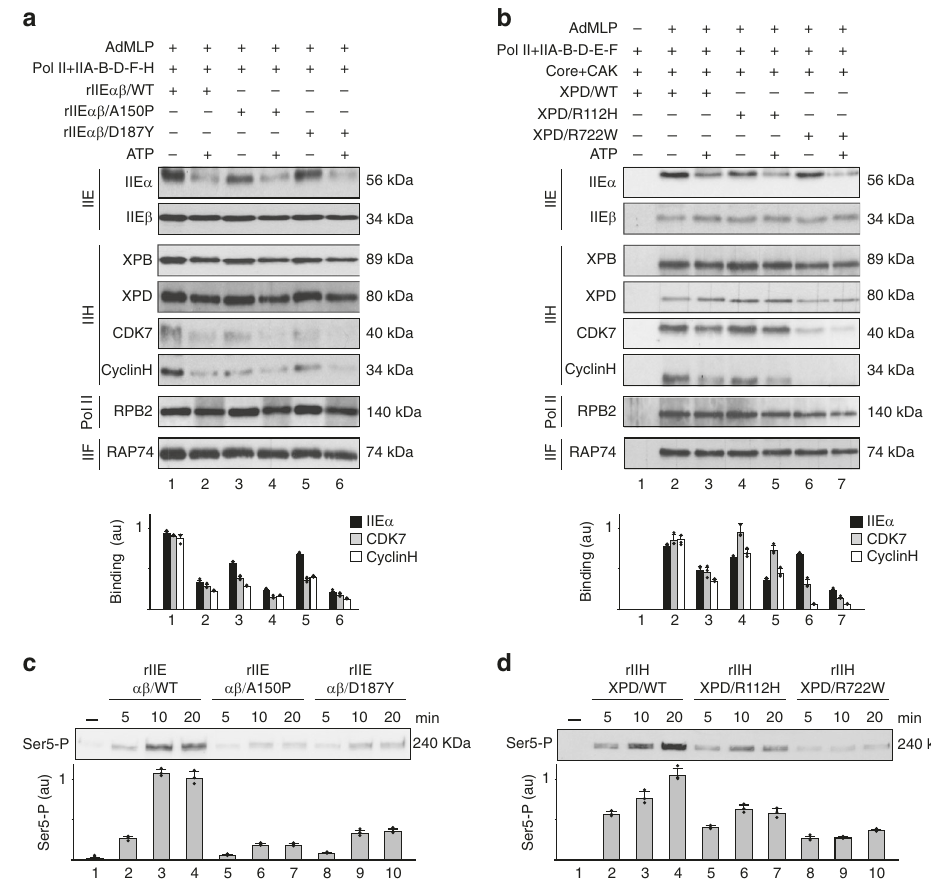
Fig. 6 TTD mutations alter CAK release and Pol II phosphorylation. a Biotinylated AdMLP bound to streptavidin magnetic beads was incubated with Pol II, TFIIA, TFIIB, TFIID (TBP), TFIIF, and TFIIH/WT, in presence (when indicated, + ) of ATP (200 μ M) and either rIIE αβ /WT, /A150P, or /D187Y. The immunoblot signals for TFIIE α , CDK7, and CyclinH were quanti fi ed and plotted in arbitrary units (a.u.). The results ( n = 3, means± s.d.) are representative of three independent experiments. b Streptavidin magnetic beads were incubated (when indicated, + ) with biotinylated AdMLP, Pol II, TFIIA, TFIIB, TFIID, rIIE αβ /WT, TFIIF, the Core-TFIIH, and the CAK, in presence of ATP (200 μ M) and either XPD/WT, /R112H or/R722W. The immunoblot signals for TFIIE α , CDK7, and CyclinH were quanti fi ed ( n = 3, means± s.d.) and plotted in arbitrary units (a.u.). The results are representative of three independent experiments. c , d In vitro reconstituted transcription systems with rIIEs ( c ) and rIIHs ( d ) have been performed in presence of cold NTPs. Immunoblot analysis next has been done using speci fi c antibody against Ser5-P of Pol II. Signals were quanti fi ed ( n = 3, means ± s.d.) and plotted in arbitrary units (a.u.). The results are representative of three independent experiments. Source data are provided as a Source Data fi (Fig. 7). Using immobilized template and highly puri fi ed